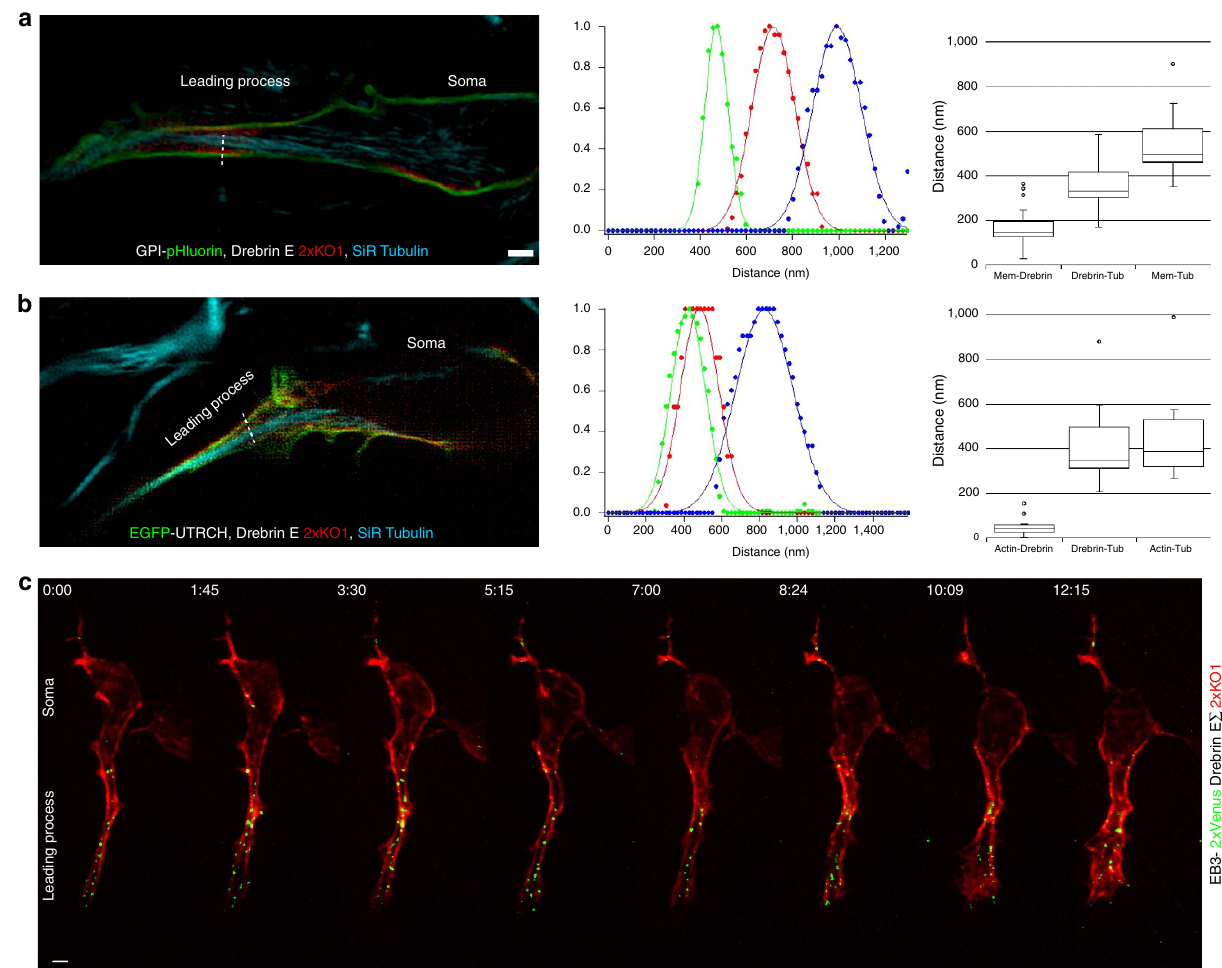
Figure 3 | SR-SIM reveals that f-actin and drebrin form a cortical collar around microtubules in the proximal leading process. ( a , b ) SR-SIM imaging of CGNs with dilated proximal leading processes expressing ( a ) GPI-pHluorin (green), drebrin E 2x-KO1 (red) and SiR-tubulin (blue; n ¼ 21 cells analysed) or ( b ) EGFP-UTRCH (green), Drebrin E 2x-KO1 (red) and SiR-tubulin (blue; n ¼ 18 cells analysed). Scale bar, 1 m m ( a ). The RGB plot to the right of each representative image shows the well-resolved Gaussian FWHM peaks detected for the line scan in each image (dashed white line). The box plots at far right show the measured distances between the centroid positions of the Gaussian peak for each fluorescent probe. Whiskers on the box plot show maximum and minimum data points, box borders show first and third quartiles and the line in the box show the median. ( c ) Drebrin is an f-actin and þ TIP binding protein. Consistent with this interaction, LLS microscopy shows that microtubule þ TIPs (labelled with EB3-2x Venus, green) pass through the drebrin E-labelled domain (labelled with drebrin E 2x-KO1, red) in the proximal leading process. Scale bar, 2 m m ( c ). Time stamp ¼